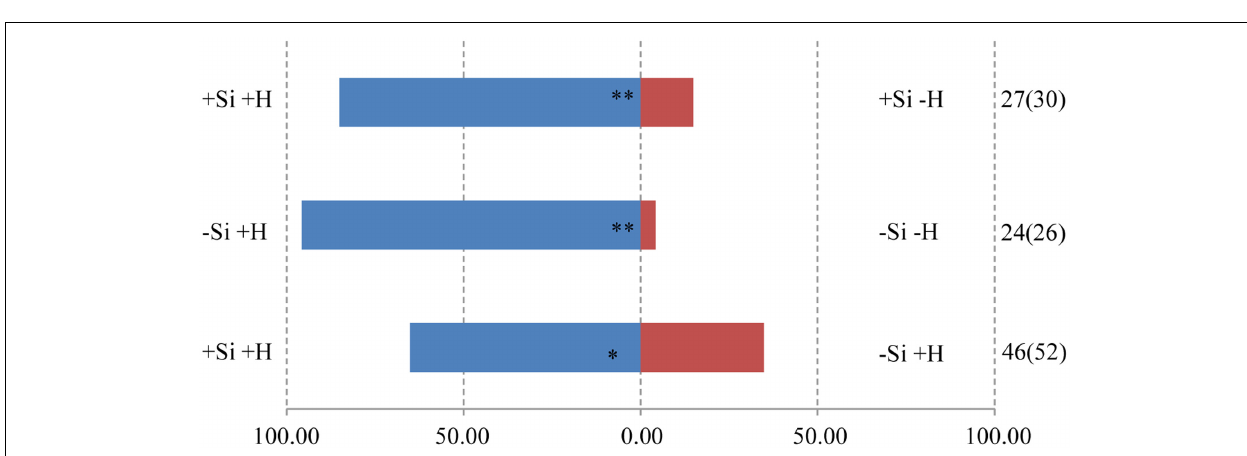
FIGURE 4 | Y-tube olfactometer response of the parasitic wasp, M. mediator to volatile profiles of WT rice plants, showing the effect of herbivore (H) ( M. separata ) infestation and silicon (Si) treatment. Asterisks indicate significant difference from a 50:50 distribution (Chi-square test; ∗ P < 0.05; ∗∗ P < 0.01; n , number of wasp individuals responding to odor source, number in parentheses means the number of wasp individuals used for test). (Statistic comparison, + Si + H vs. + Si − H, χ 2 = 13.370, P = 0.000256; − Si + H vs. − Si − H, χ 2 = 20.167, P = 0.000007; + Si + H vs. − Si + H, χ 2 = 4.261, P = 0.039). % parasitic wasps to plant odour